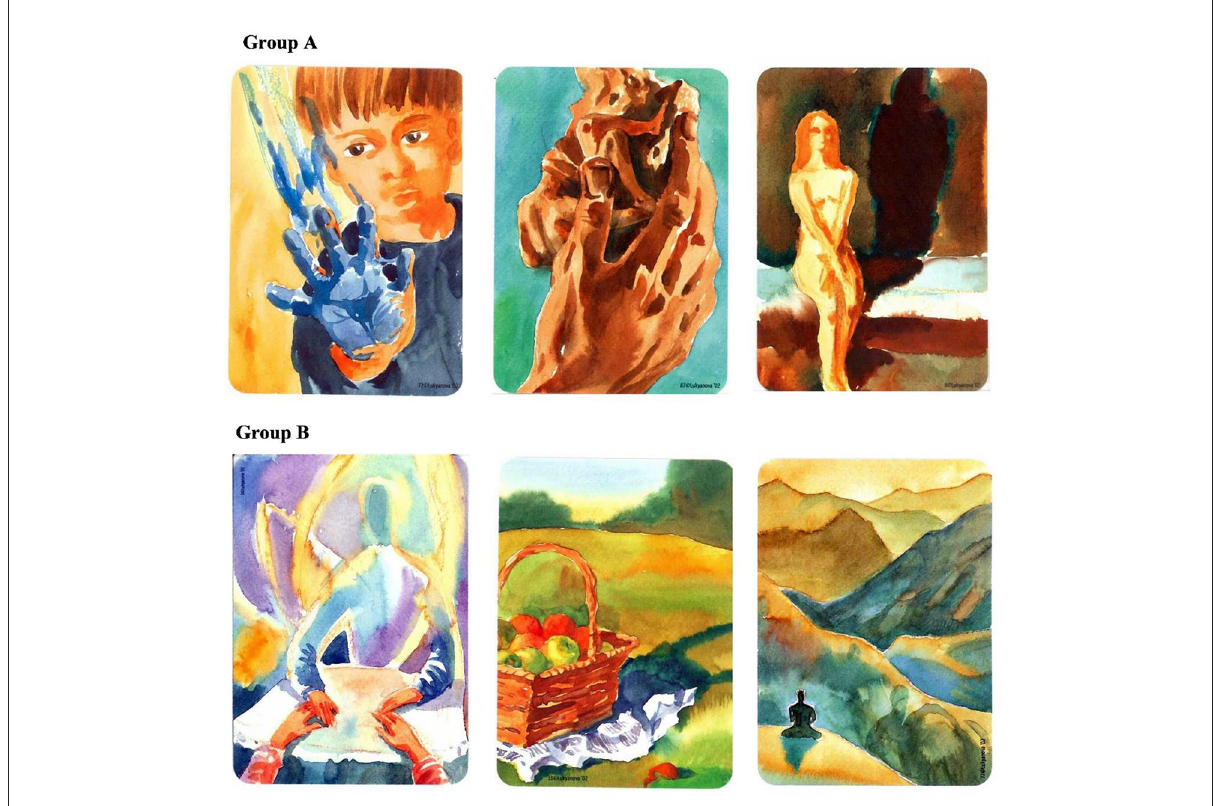
FIGURE1 Examples of arousing negative (A) and relaxing positive (B) COPE cards used in this